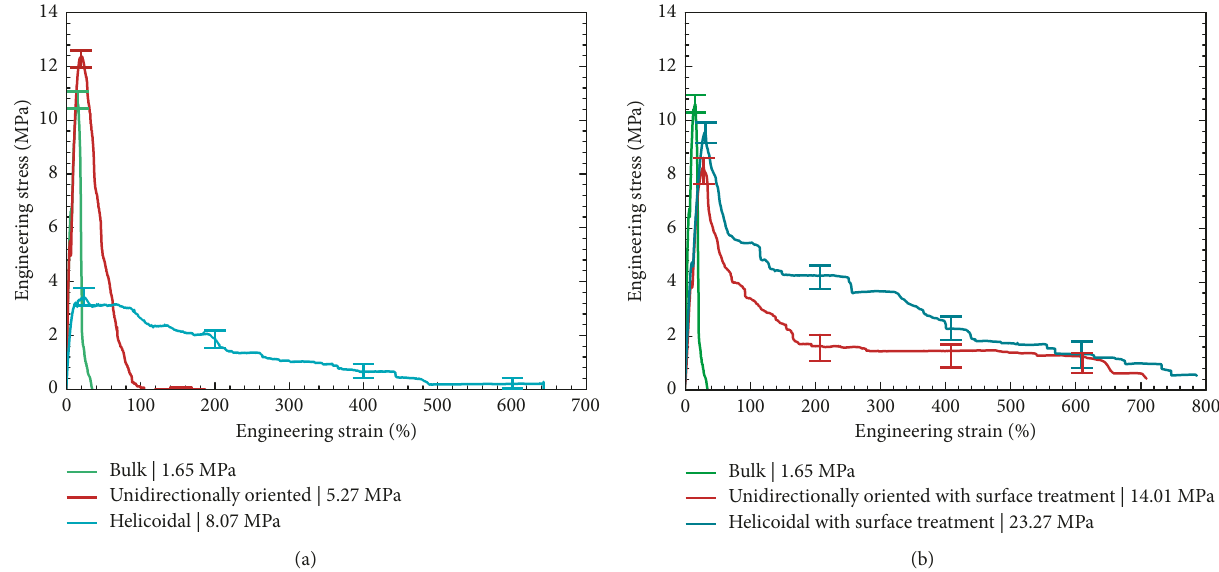
Figure 5: Stress-strain curves and toughness measurements. (a) Bulk PCL in comparison with unidirectionally oriented PCL fibre sample and helicoidal PCL fibre sample without surface treatment. (b) Bulk PCL in comparison with surface-treated unidirectionally oriented PCL fibre sample and surface-treated helicoidal PCL fibre sample. The experimental error bars are provided here to indicate variations within each group of the samples at max stress values and subsequently at strain values of 200%, 400%, and 600%. The variations of the max stress values in each of the groups are not more than ± 6%. The toughness, as defined by the area under the stress-strain curve, for each of the groups of samples has been provided in the legend (the toughness is presented here with the unit of MPa × unitless